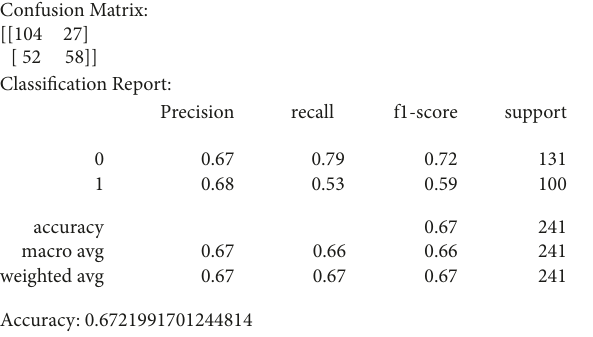
Figure 9: RF confusion matrix, classification report, and accuracy.